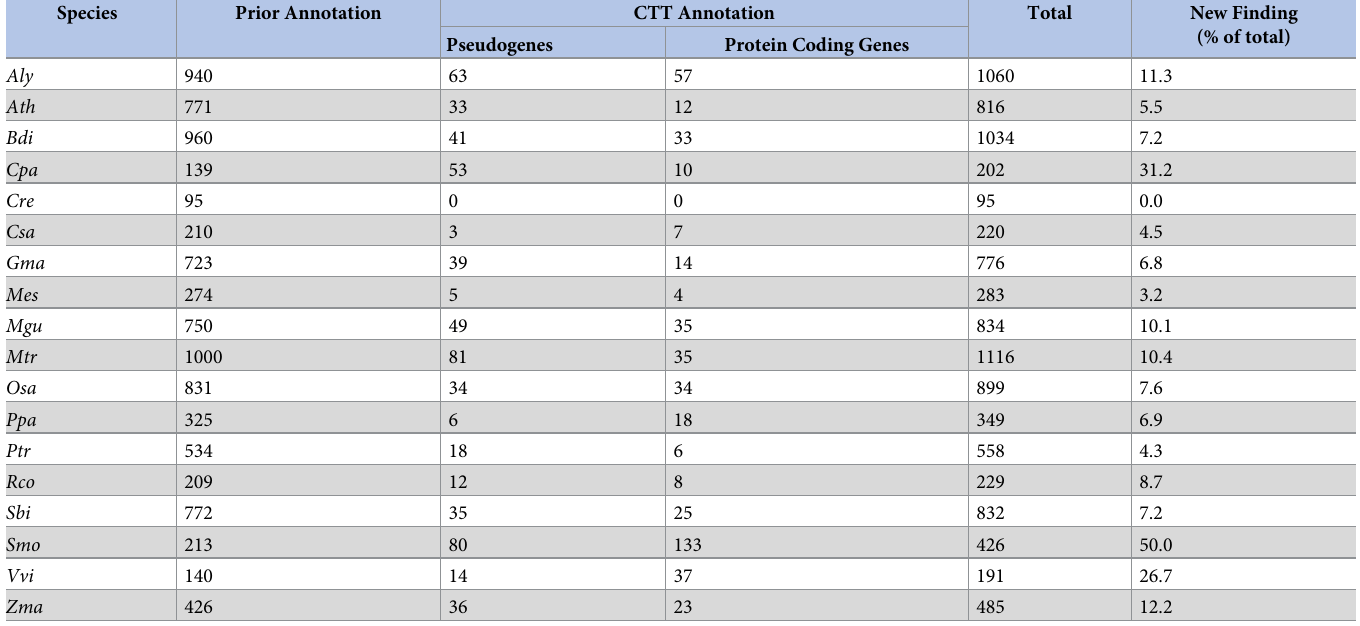
Table 3. CTT annotation of F-box genes in 18 plant genomes.